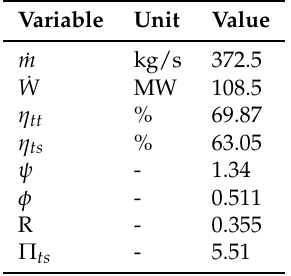
Table 9. 3D CFD performance results.